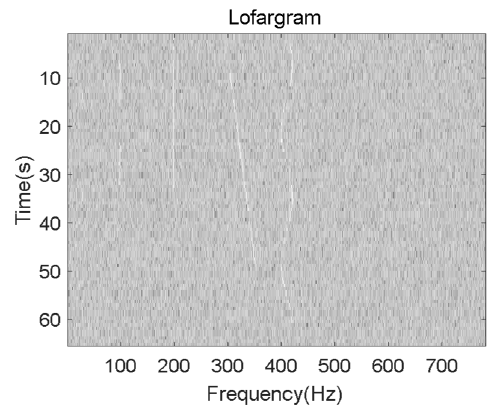
Figure 10. Lofargram after background equalization.